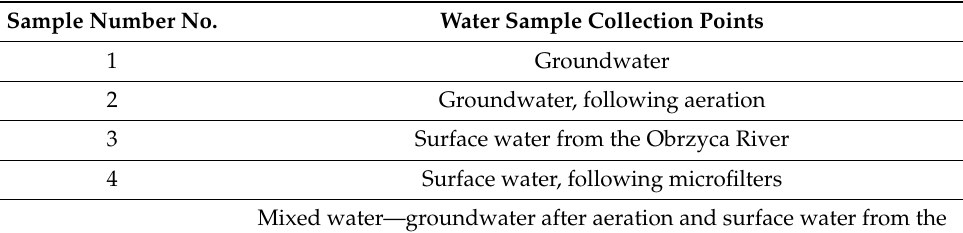
Table 6. Water sample collection points after subsequent stages of water treatment. Sample Number